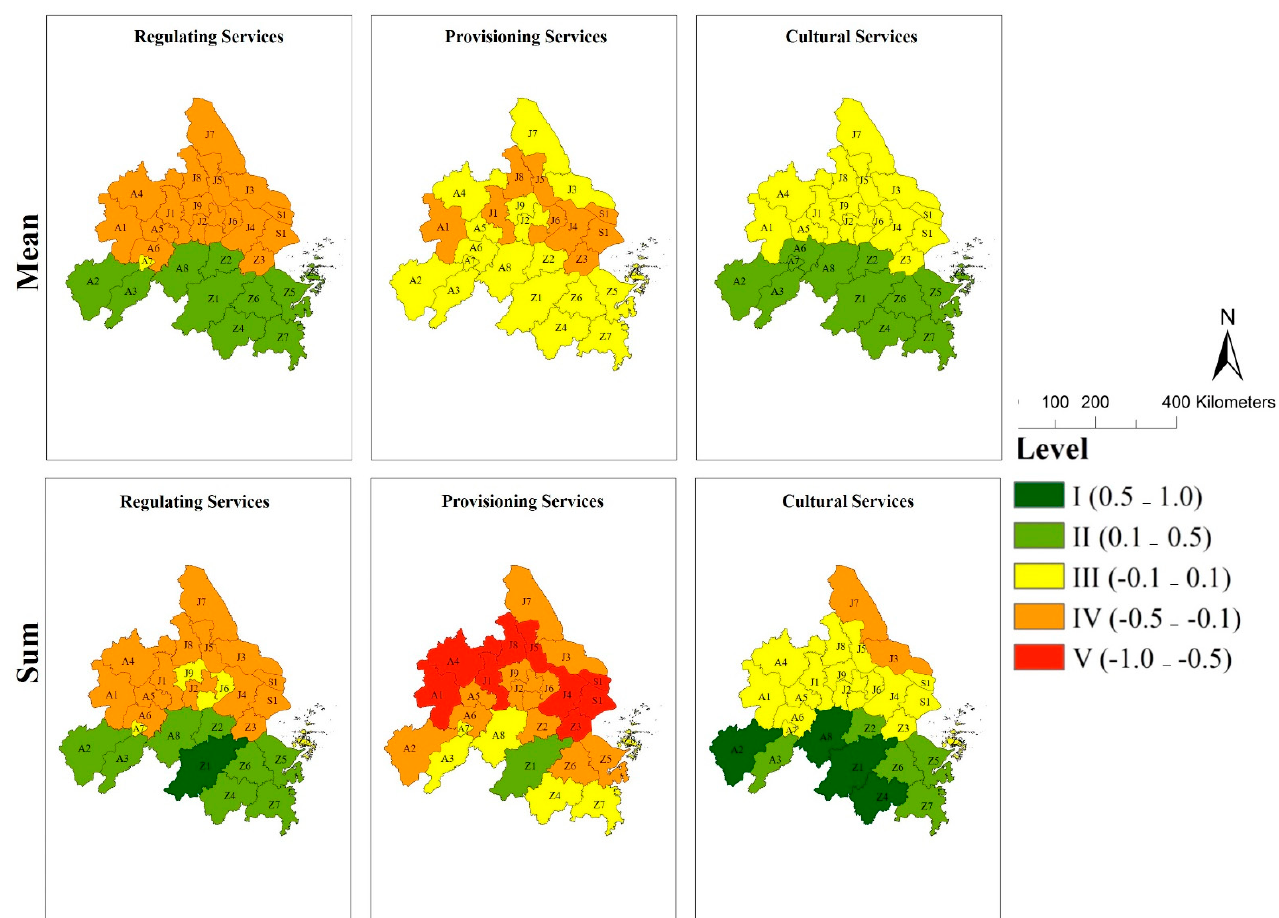
Figure 4. Spatial Pattern and Levels of Mean and Sum of Regulating Services, Provisioning Services and Cultural Services: (A1) Hefei, (A2) Anqing, (A3) Chizhou, (A4) Chuzhou, (A5) Ma’anshan, (A6) Tongling, (A7) Wuhu, (A8) Xuancheng in Anhui Province; (J1) Nanjing, (J2) Changzhou, (J3) Nantong, (J4) Suzhou, (J5) Taizhou ‐ J, (J6) Wuxi, (J7)Yancheng, (J8) Yangzhou, (J9) Zhenjiang in Jiangsu Province; (S1) Shanghai Municipality; (Z1) Hangzhou, (Z2) Huzhou, (Z3) Jiaxing, (Z4) Jinhua, (Z5) Ningbo, (Z6) Shaoxing, (Z7) Taizhou ‐ Z, and (Z8) Zhoushan.